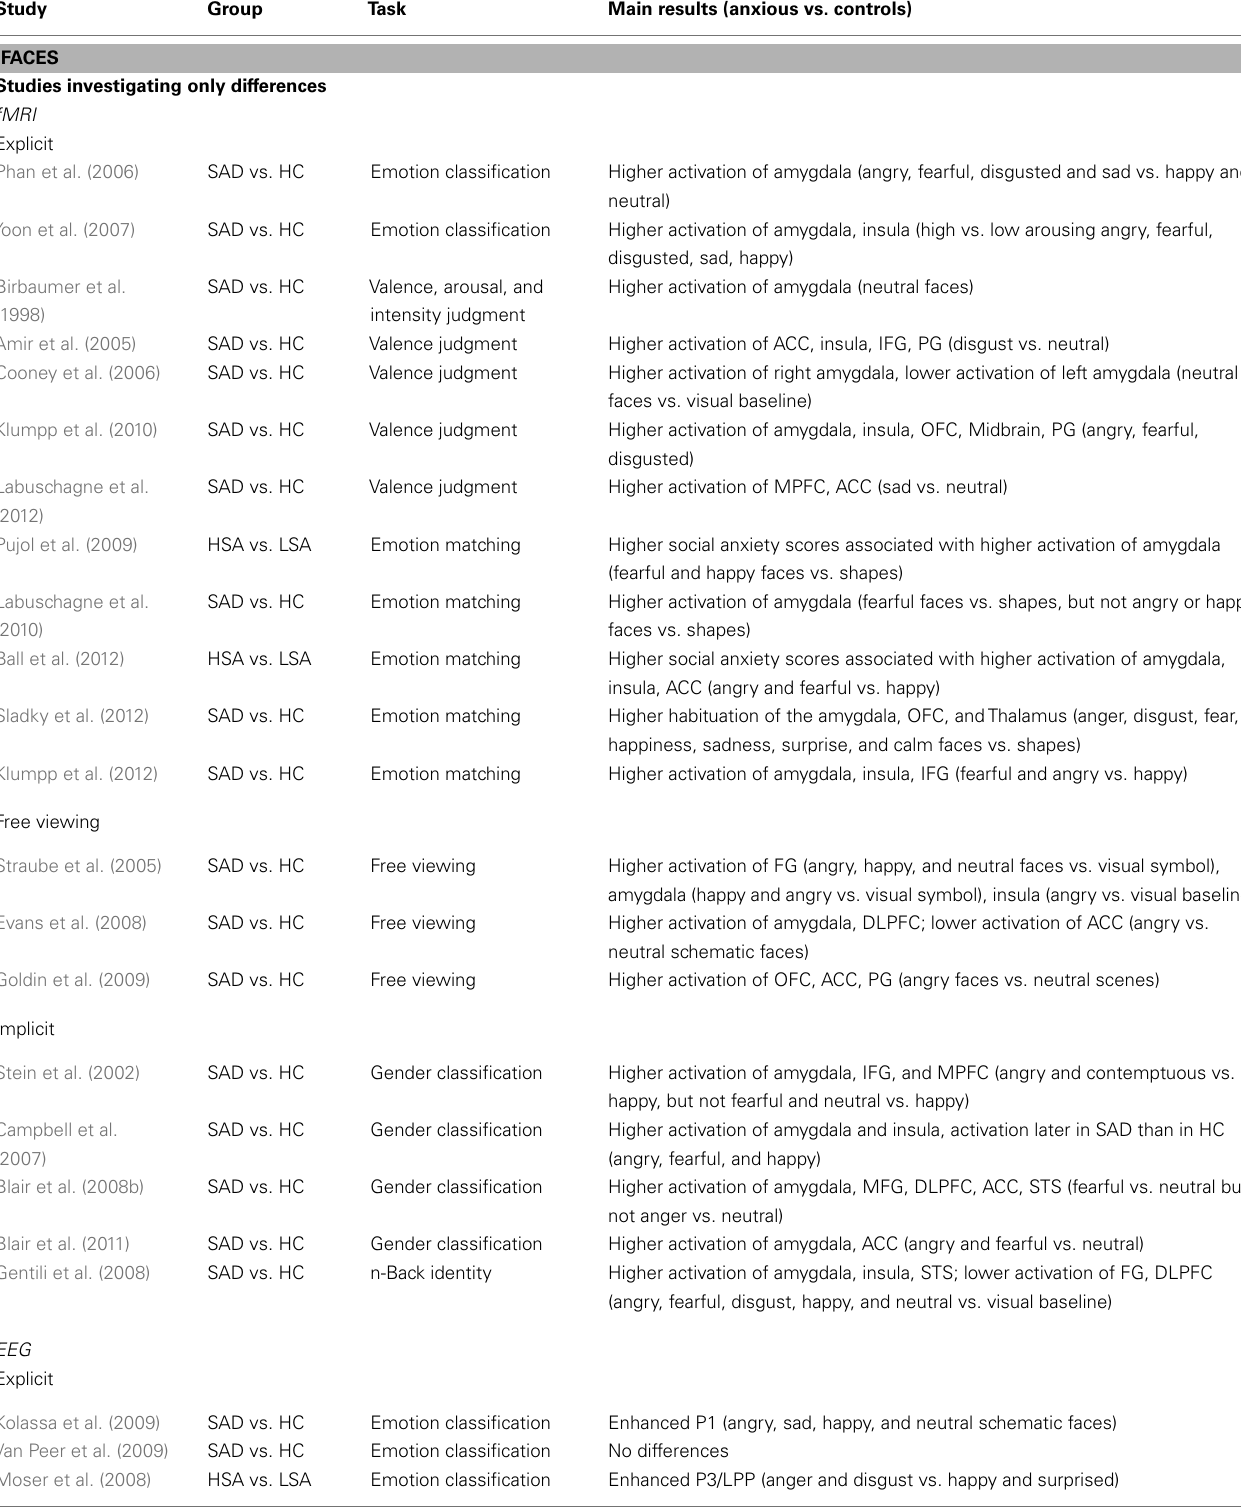
Table 1 | Studies investigating automatic processing by means of facial expressions, voices, and words.